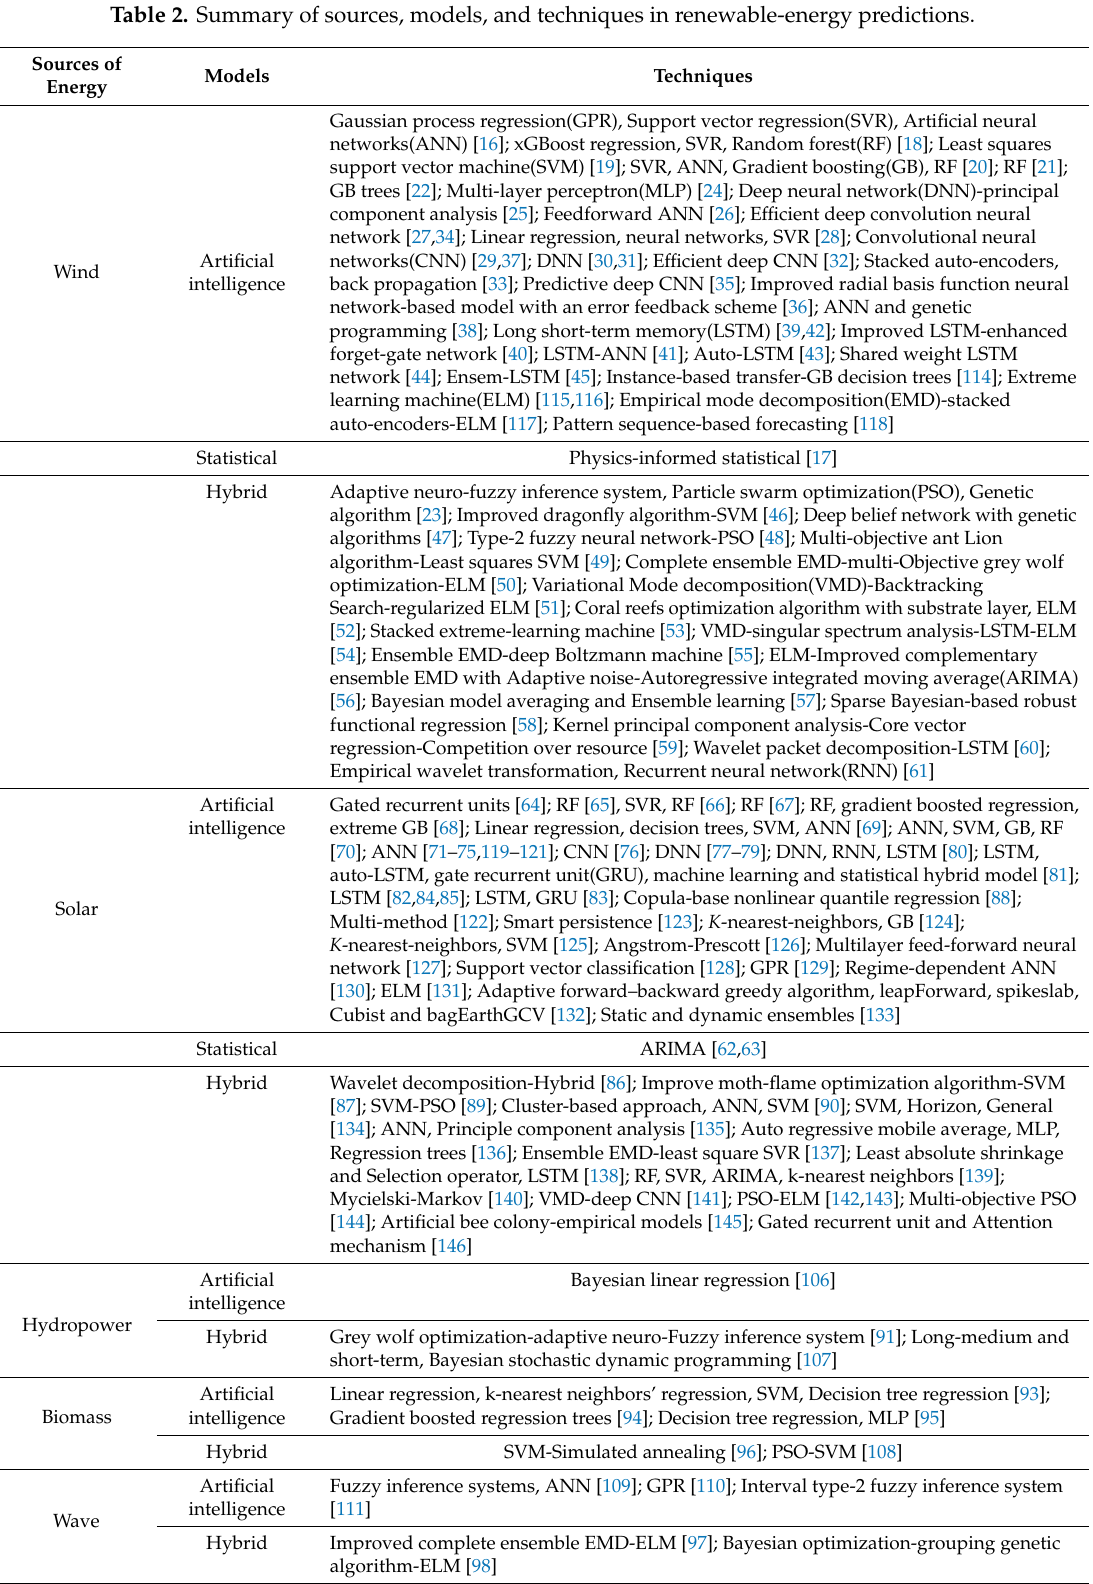
Table 2. Summary of sources, models, and techniques in renewable-energy